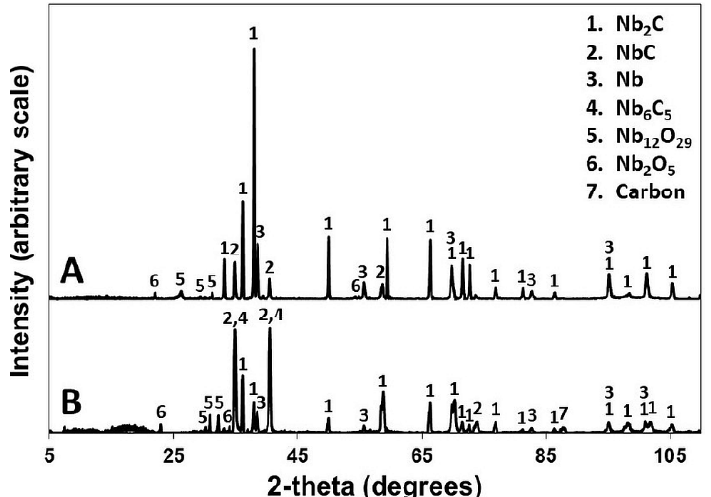
Fig. 7 . X-ray diffractograms of the niobium coating surface (A) and the coating-graphite interface (B). The coating surface mostly contains niobium rich carbides and niobium oxides, whereas the interface is com- posed of carbon rich niobium carbides and niobium